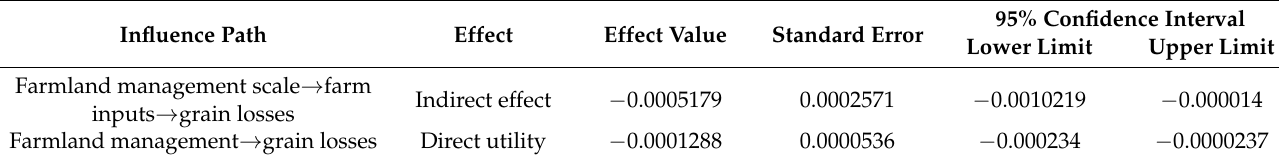
Table 7. Bootstrap